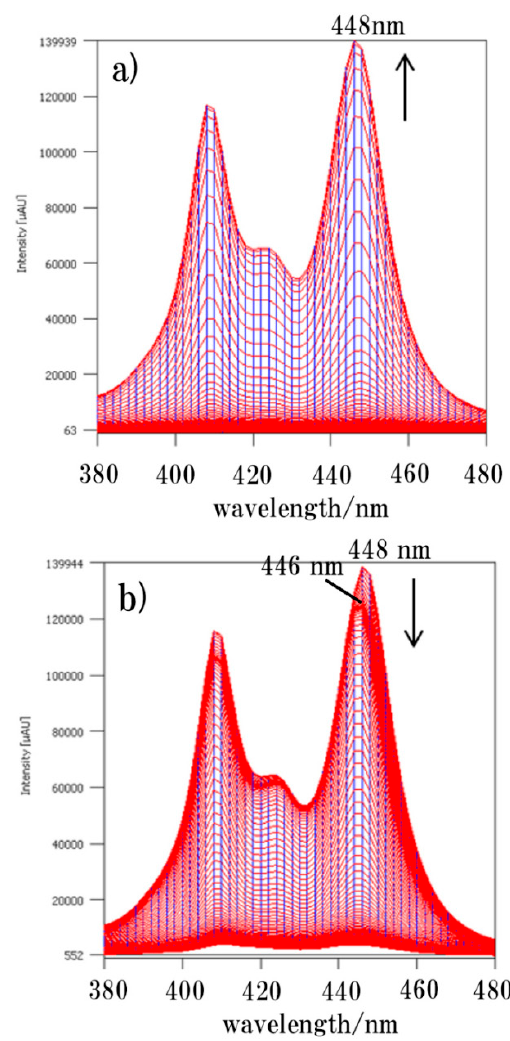
Figure 16. ( a ) UV-vis spectra of PEG8-GP1 overlaid before the peak maximum (17. 8 min) in Figure 15c. ( b ) Overlaid after the peak maxmum in Figure 15c. The maximum wavelength is shifted from 448 to 446 nm in ( b ).